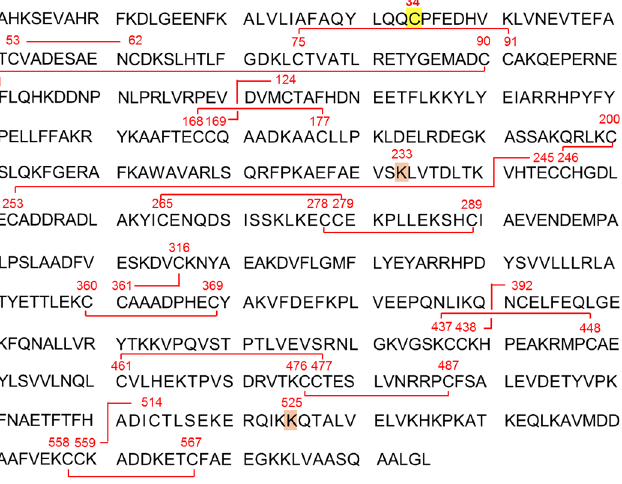
Figure 1. Amino acid sequence of human serum albumin (ALB). Human serum ALB, which is presented in the single-letter amino acid code, consists of a polypeptide chain of 585 amino acid residues including 35 cysteine (Cys) residues. Thirty-four of Cys residues form disulfide bridges, while the remaining single Cys residue at position 34 is free and redox-active. Cysteinylation, homo- cysteinylation, sulfinylation on Cys34 and glycosylation on lysine residue at position 233 (Lys233) and Lys525 have been confirmed [9].